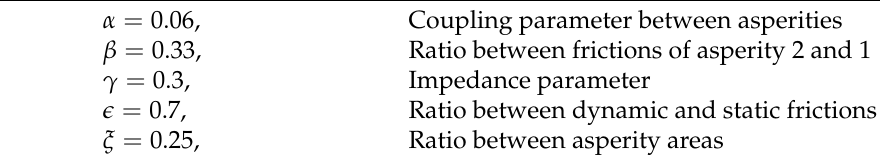
Table 2. Values of model